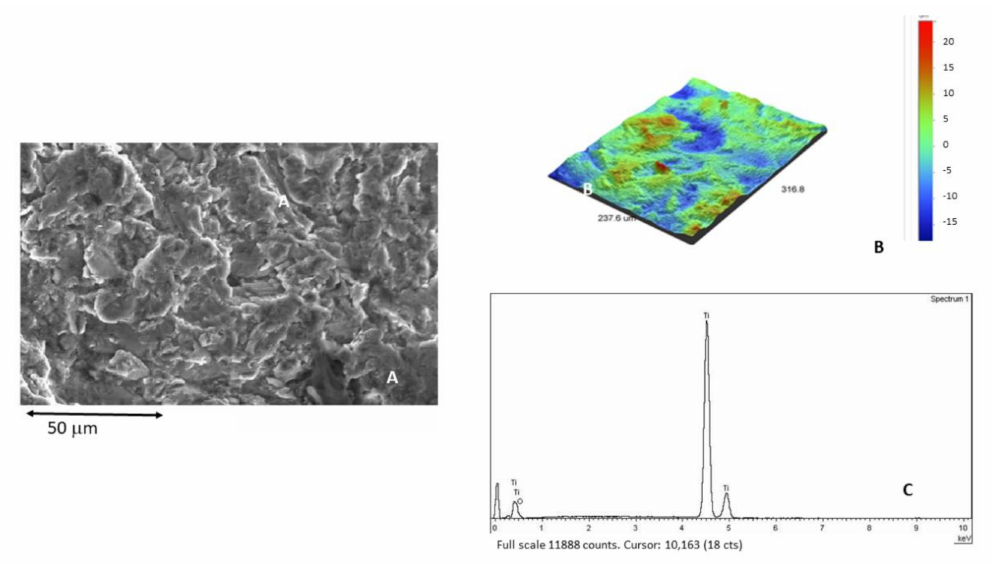
Figure 5. ( A ) Titanium surface after the cleaning process. ( B ) 3D interferometric image of titanium surface without alumina particles. ( C ) X-ray microanalysis not showing the presence of